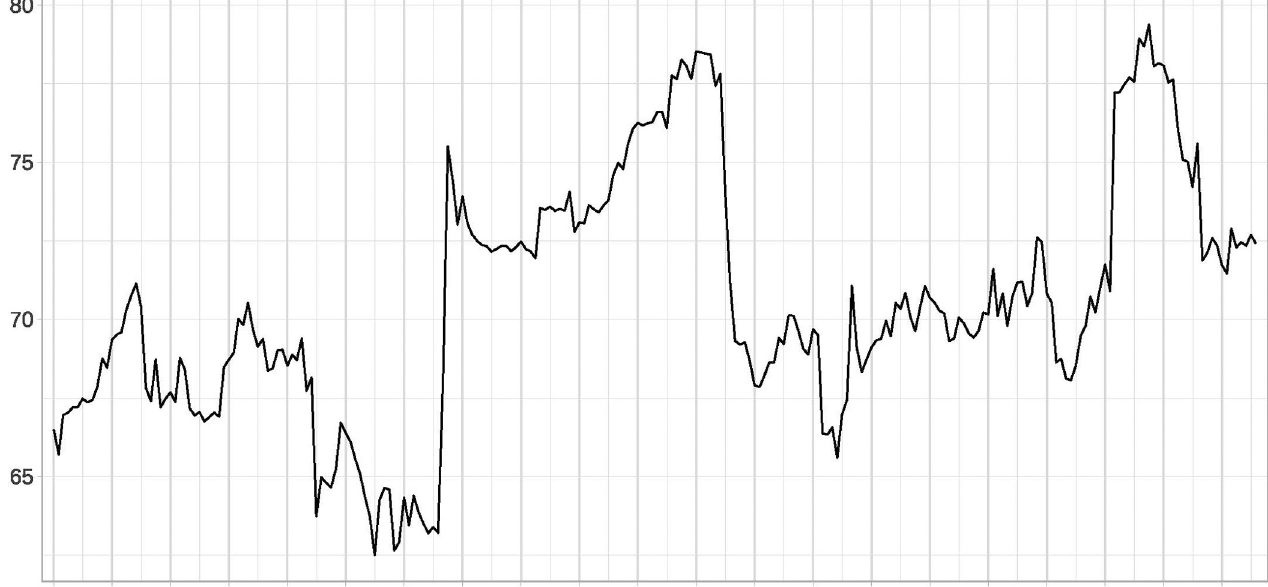
Fig 1. Time-varying characteristics of the total spillover of the network of global EPU and ERV. (i) This figure plots the total spillover between global EPU and ERV for a 60-month rolling window. (ii) Since we use a rolling window of 60 months and our sample starts in 1997, the starting year of this figure is 2002.